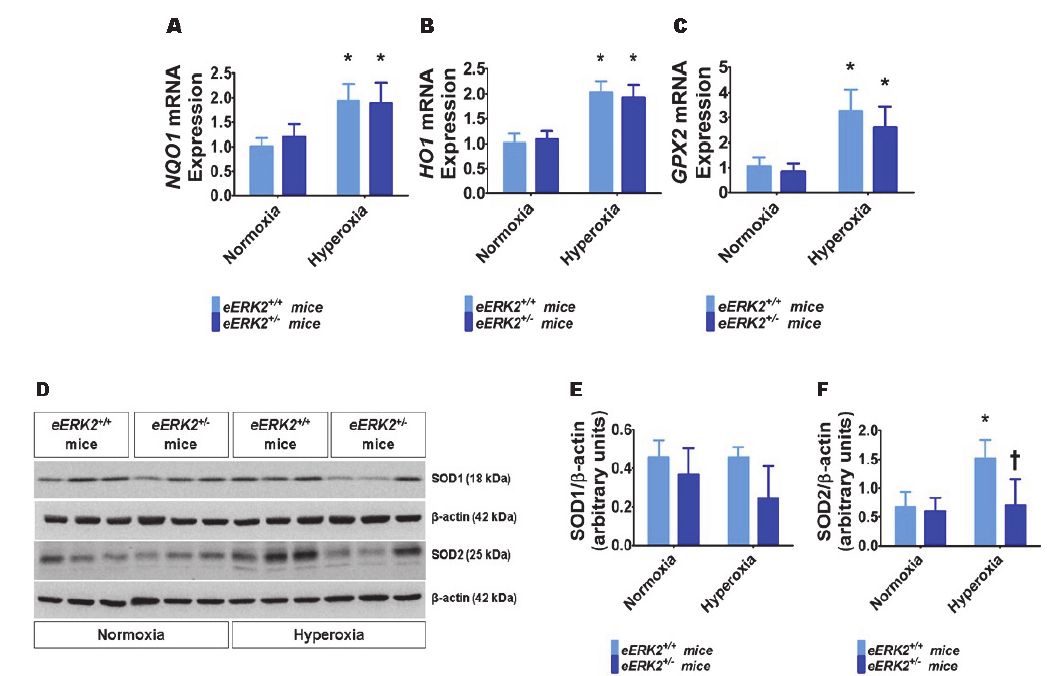
Figure 7. Lung oxidative stress in endothelial ERK2 -sufficient ( eERK2 +/+ ) or –deficient ( eERK2 +/ − ) mice exposed to hyperoxia. One-day-old eERK2 +/+ or eERK2 +/ − mice were exposed to either 21% O 2 (normoxia) or 70% O 2 (hyperoxia) for one week, following which the lung tissues were harvested for gene expression studies. ( A – C ) RT-PCR analyses-based determination of NQO1 ( A ), HO1 ( B ), and GPX2 ( C ) mRNA levels. ( D ) Determination of SOD1 and SOD2 protein levels by immunoblotting. ( E , F ) Quantification and normalization of SOD1 ( E ) and SOD2 ( F ) band intensities to those of β -actin. Values are presented as mean ± SD ( n = 5–6/genotype/exposure). Significant differences between normoxia and hyperoxia groups are indicated by *, p < 0.05 (ANOVA).